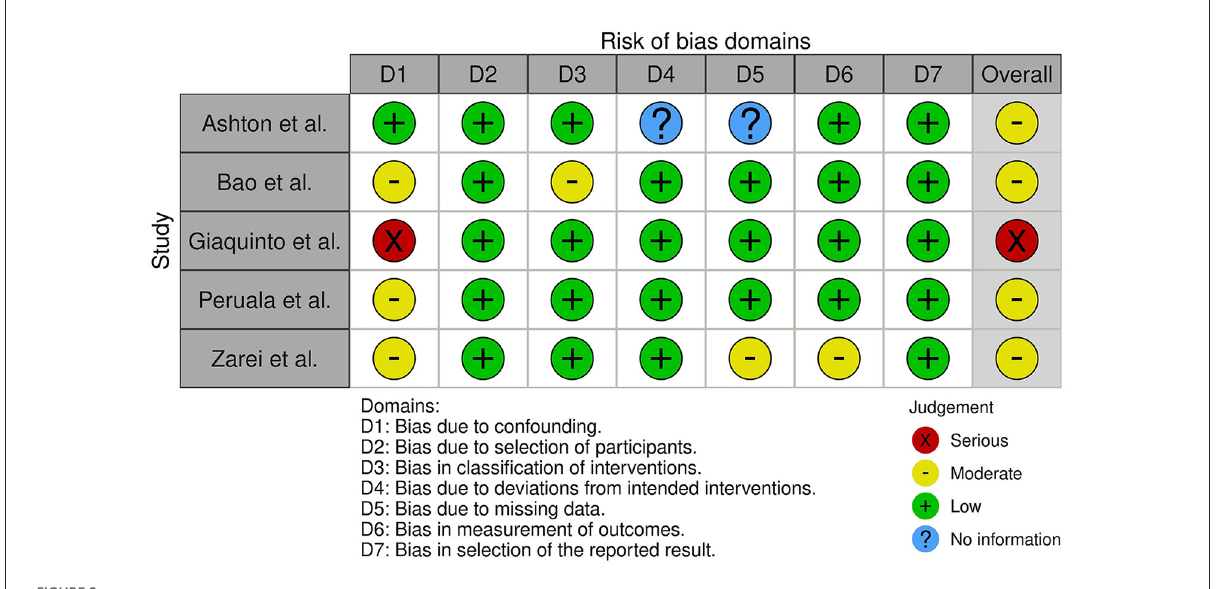
FIGURE2 Results of the ROBINS-I tool to assess risk of bias